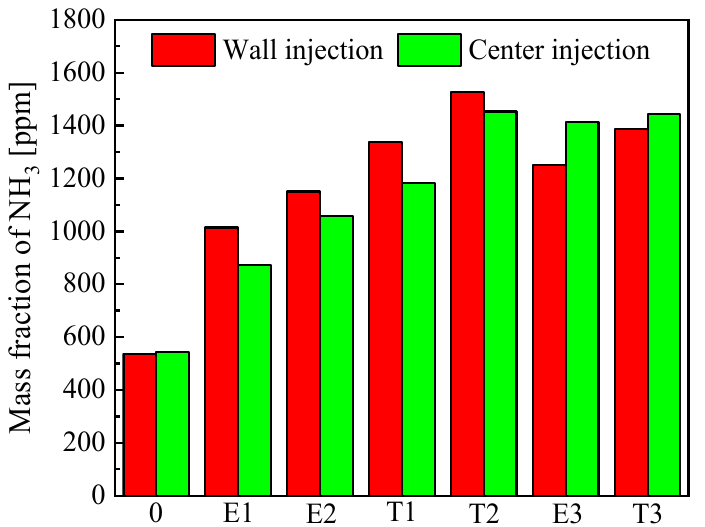
Figure 7. The NH 3 volume-averaged concentration.